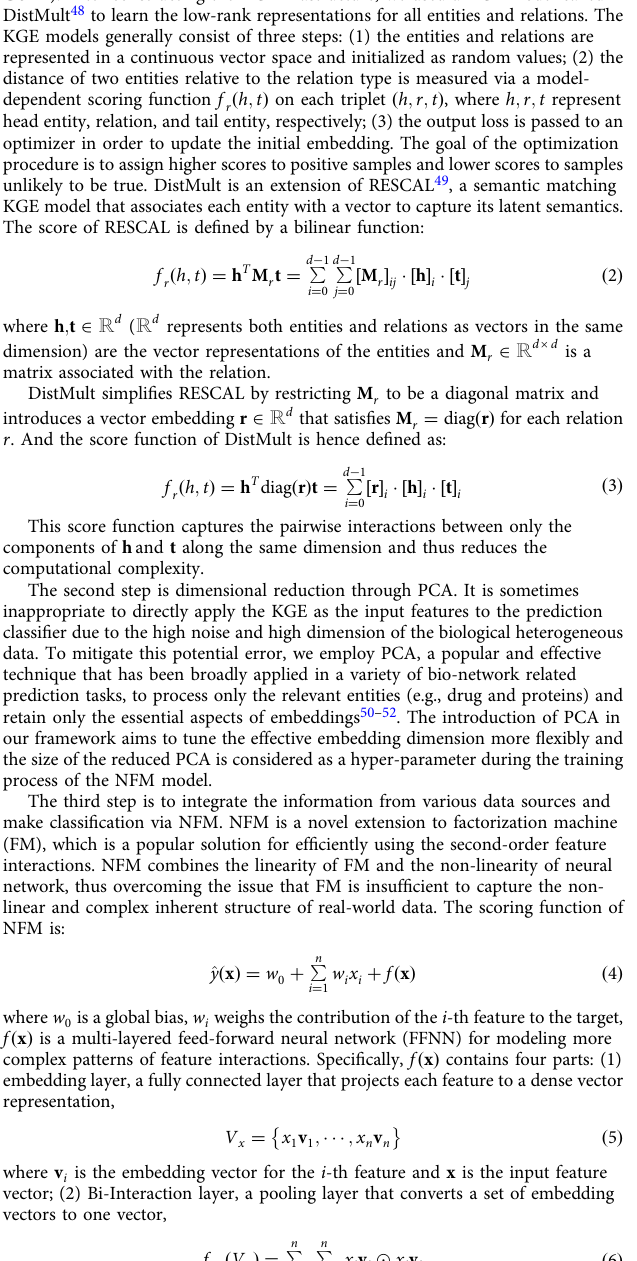
Fig. 6 Network analyzer and one case to illustrate how to improve DTI predictive performance. a Betweenness centrality distribution of the network consisting of DTI data and all KG. Degree means the number of the edges linked to a node. The betweenness centrality of a node re fl ects the amount of the control that this node exerts over the interactions of the other nodes in the network. b The visualization of the KG related to the selected DTI (D00964 and has:1553), where the green points represent proteins, the blue points represent heterogeneous information and the red points represent drugs. c Betweenness centrality distribution of the network for the KG related to the selected DTI (D00964 and has:1553). d The visualization of the selected DTI (D00964 and has:1553) related knowledge graph with removing the nodes and related edges of KEGG_GENE, KEGG_Drug and KEGG_PATHWAY. e Betweenness centrality distribution of the network consisting of the selected DTI (D00964 and has:1553) related KG with removing the nodes and related edges of KEGG_GENE, KEGG_Drug